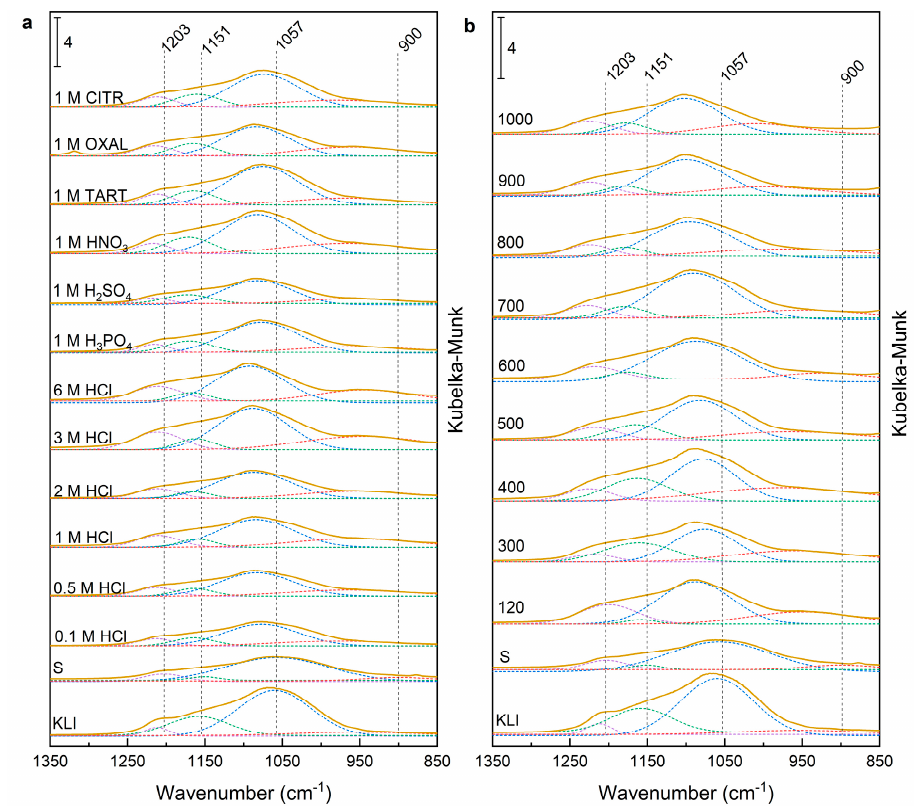
Figure 4. Deconvolution of the main band of DRIFT spectra in the range 850–1350 cm − 1 for acid leached zeolite foams ( a ) and for calcined zeolite foams ( b ). Deconvolution curves: Measured curve (yellow), 1st deconvolution peak (violet), 2nd deconvolution peak (green), 3rd deconvolution peak (blue), 4th deconvolution peak